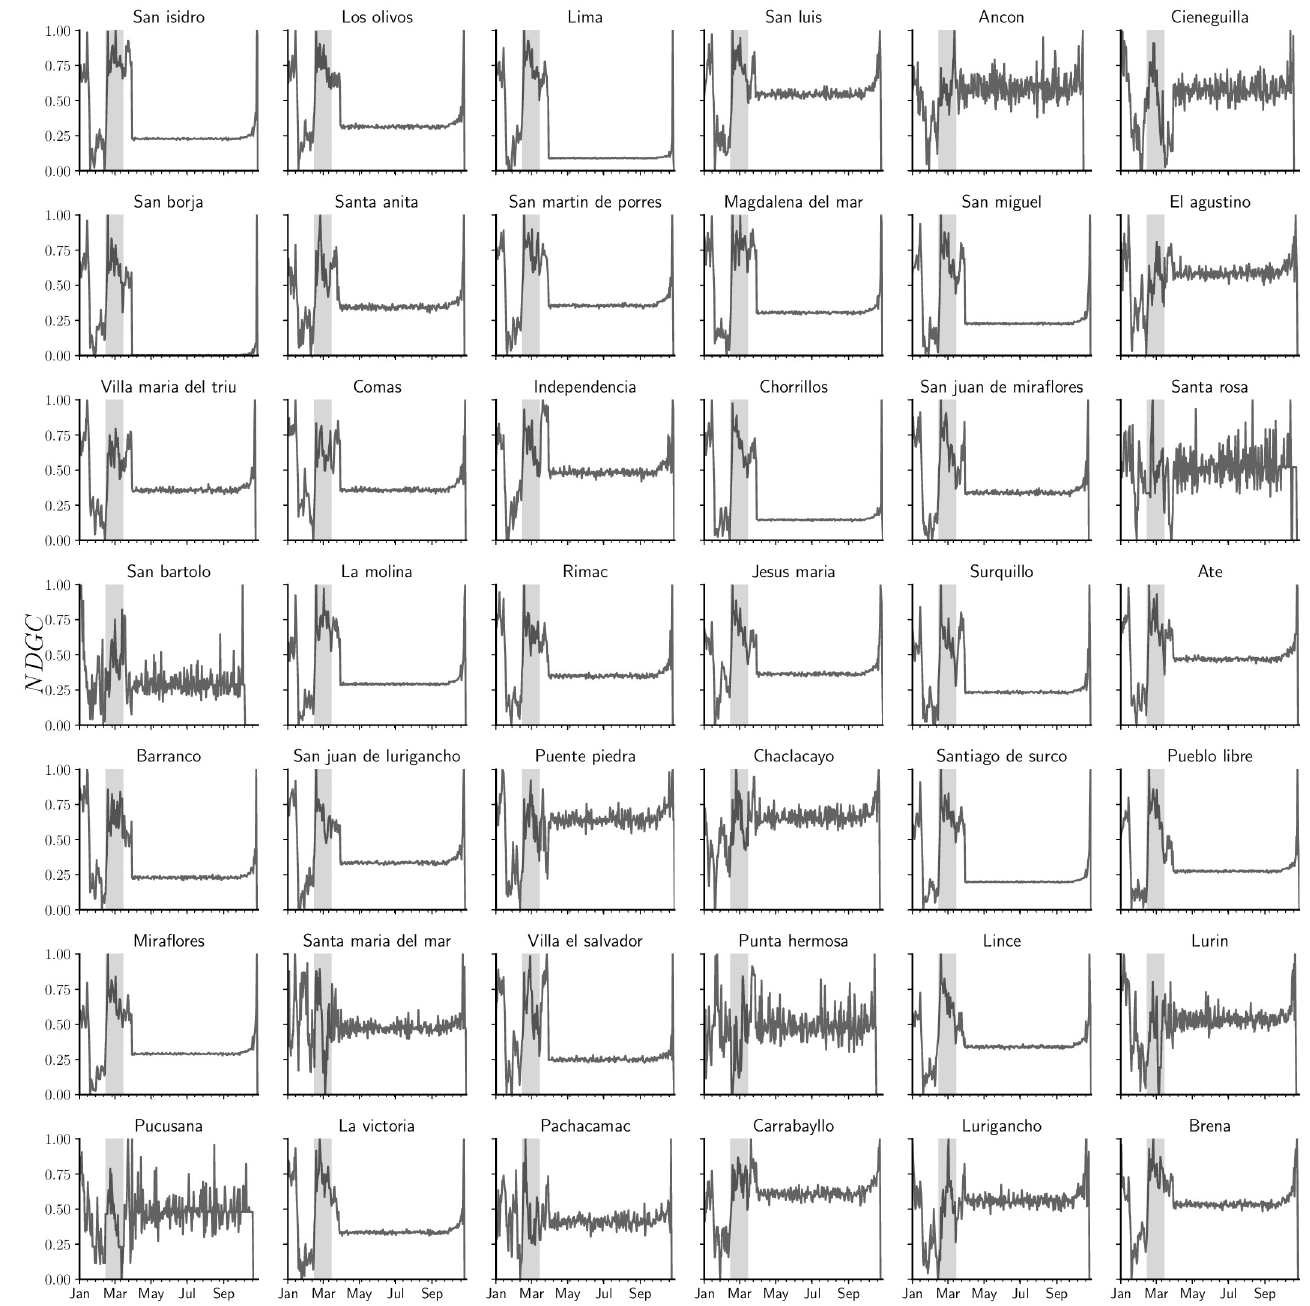
Fig 5. Average variation of purchase category composition. Stationary vectors of the mobility Markov chain models were used as input and were built from four weeks of consumption by a week for the normalized discounted cumulative gain (NDCG) gain for all individuals living in a given district.